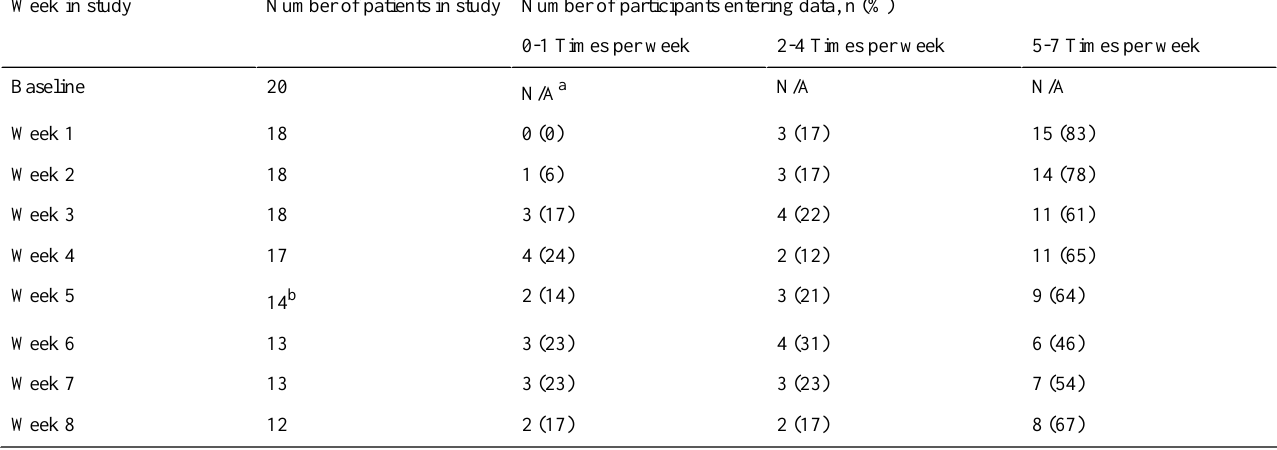
Table 2. Completeness of data entry by